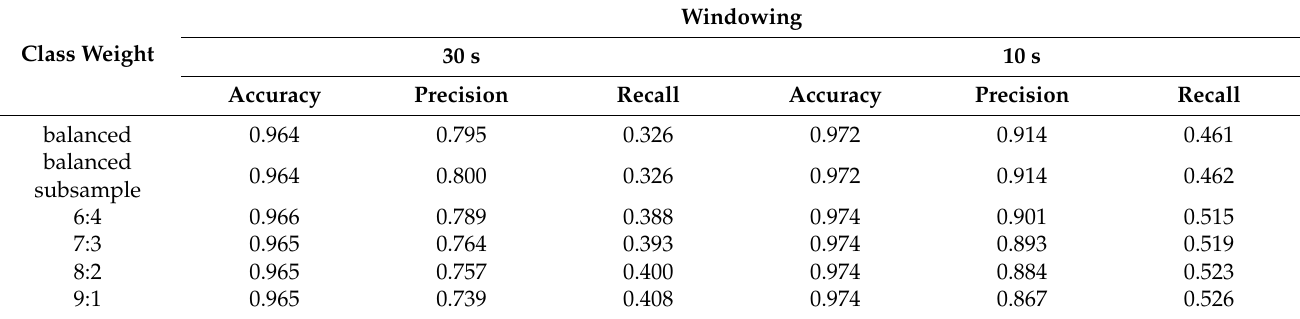
Table 4. Prediction results according to different weights on the